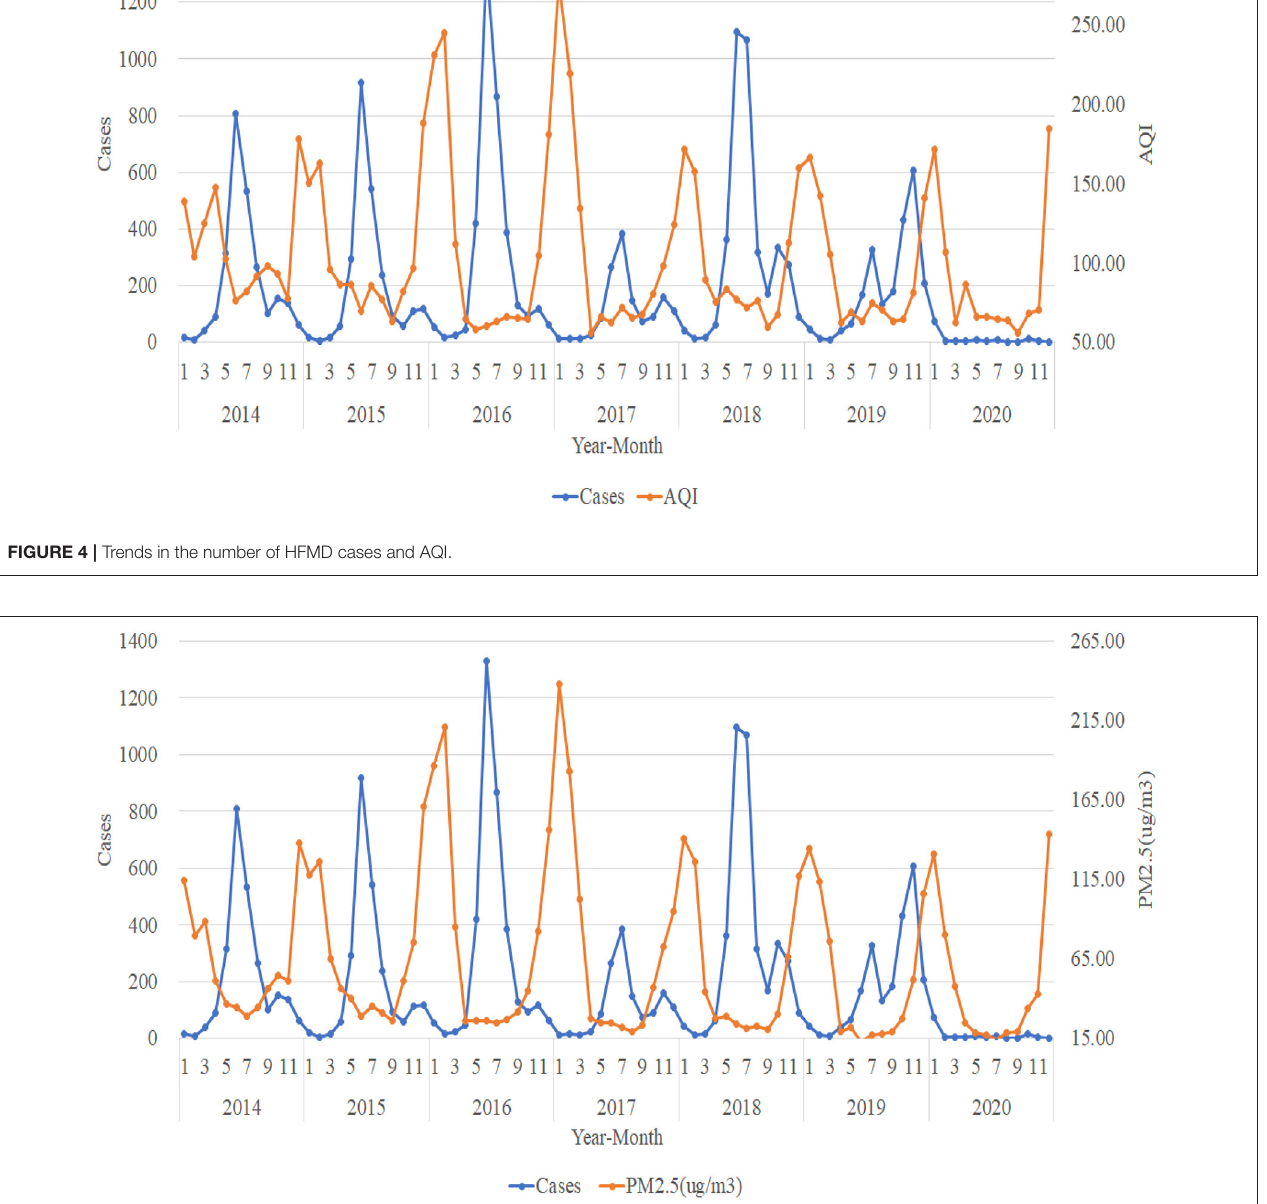
pressure, while Guangzhou is located on the southeast coast of China with an average elevation of 11 m above sea level, low elevation, and high average station pressure. Zhao et al.